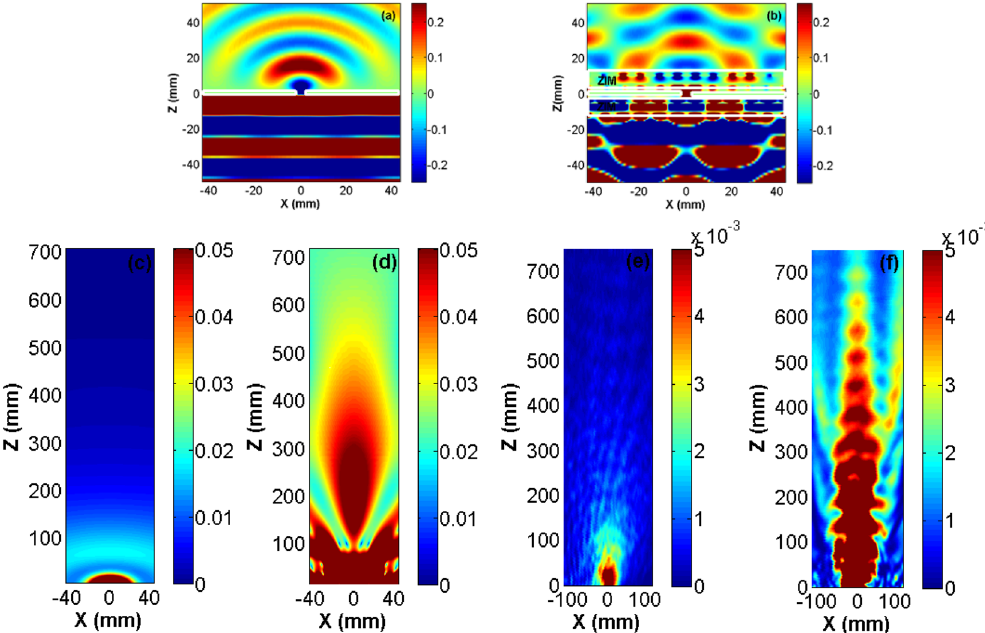
Figure 3. ( a ) and ( b ), respectively, illustrate numerical real part of the E x component of the field distributions for the bare aperture and ZIM / A / ZIM system, at f = 12.7 GHz . In these figures, as indicated by the white regions, the aperture is placed at the origin, and ZIM is extended within Z = − 12 to − 1 mm (1 to 12 mm ) at the inner (outer) side of it in panel (b). Panels (c) and (d) also numerically represent the corresponding far-field distributions of electric field intensity at the enhancement frequency. In agreement with the numerical results, the experimental far-filed mode profiles are illustrated in panels (e) and (f).